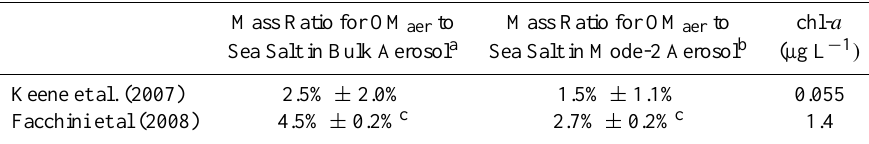
Table 1. Mass ratios expressed as percentages of mean OM aer to inorganic sea salt for bulk and mode-2 aerosol and corresponding mean chl- a concentrations in surface seawater. Uncertainties correspond to reported variability in